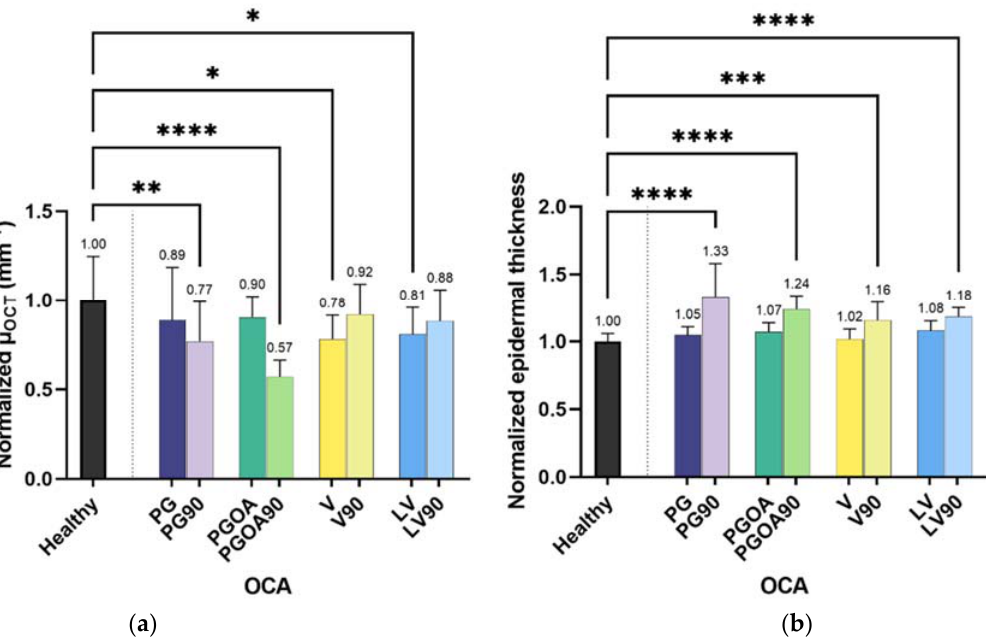
Figure 2. Normalized changes in the signal attenuation coefficient µ OCT ( a ) and in epidermal thickness ( b ) of non-treated skin after the application of four different OCAs at two different times t 1 = 5 min and t 2 = 90 min (x-axis, no name suffix and suffix “90”, respectively). The number of asterisks denotes the decreasing p -value whereas p ≤ 0.05, p ≤ 0.01, p ≤ 0.001 and p ≤ 0.0001 are symbolized by 1–4 asterisks. Raw mean values are presented in Tables S1 and S2 (Supplementary Infor- mation).